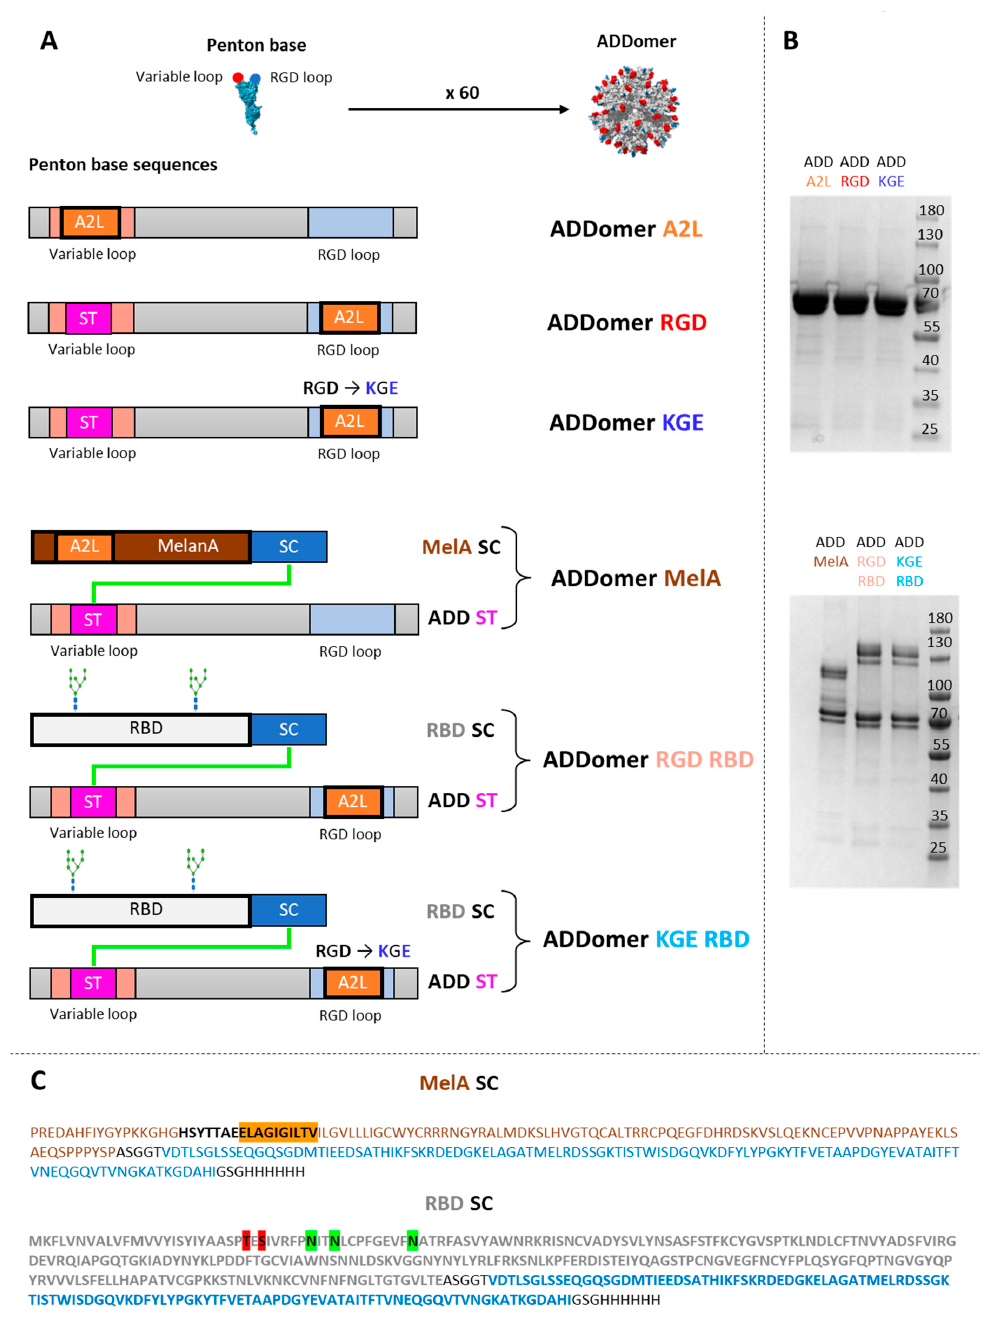
Figure 1. Design and characterization of the different ADDomers . ( A ) Diagram showing the insertion of the A2L epitope (A2L in orange) and SpyTag (ST in pink) in the 2 loops of the ADDomer monomer. SpyTag can make an isopeptidic bond with SpyCatcher (SC in blue) fused to the RBD protein (in grey) or the MelanA protein (MelA in brown). ( B ) SDS-PAGE profiles of reduced and boiled samples of the different ADDomers showing the apparition of a higher MW covalent adduct for the ADD-MelA (ADD-ST/MelA-SC), ADD KGE RBD (ADD-KGE/RBD-SC) and ADD RGD RBD (ADD-RGD/RBD-SC). ( C ) Sequences of the MelA-SC and RBD-SC. In the MelA-SC sequence, the MelanA tumor antigen is colored in brown (A2L epitope is highlighted in orange), SpyCatcher is colored in blue and additional linkers and histidine tag are colored in black. In the RBD-SC sequence, the Spike Receptor Binding Domain of SARS-CoV-2 is colored in grey (N and O-glycosites are highlighted, respectively, in green and red), SpyCatcher is colored in blue and additional linkers and histidine tag are colored in